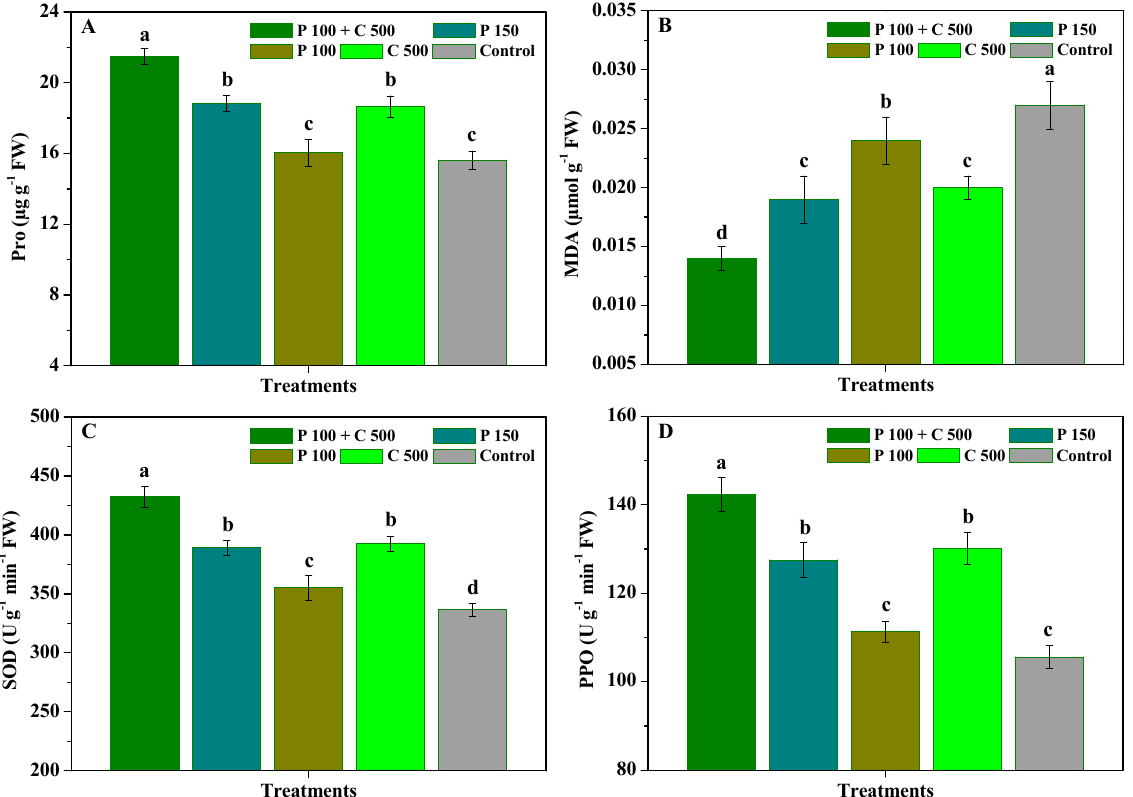
Figure 3. The influence of pyraclostrobin and chitosan on the Pro ( A ), MDA ( B ), SOD activity ( C ), and PPO activity ( D ) of R. roxburghii leaves. Error bars indicate the SD of the three replicates. Small letters represent significant differences on a 5% ( p < 0.05) level.